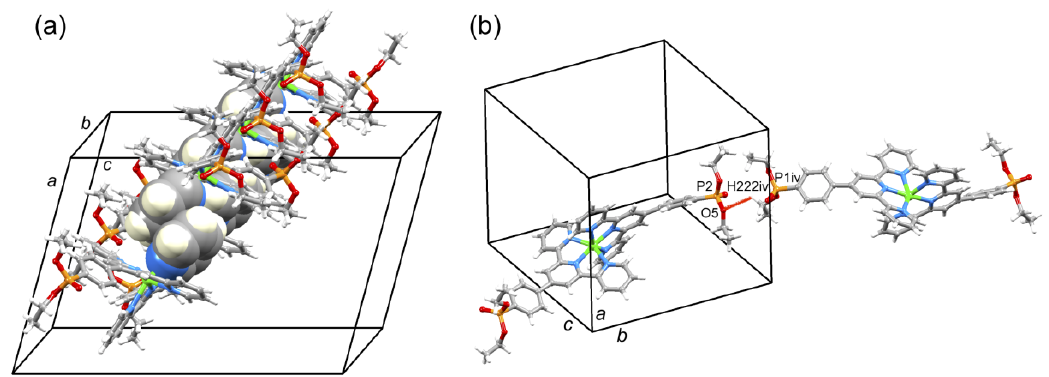
Figure 8. ( a ) Part of one chain of [Zn( 2 ) 2 ] 2+ cations in [Zn( 2 ) 2 ][CF 3 SO 3 ] 2 supported by pyridine...pyridine π -stacking interactions. ( b ) Short PO...HC contact between phosphate ester groups of adjacent cations. Symmetry code iv = 1 / 2 − x , 3 / 2 + y , 1 / 2 − z .